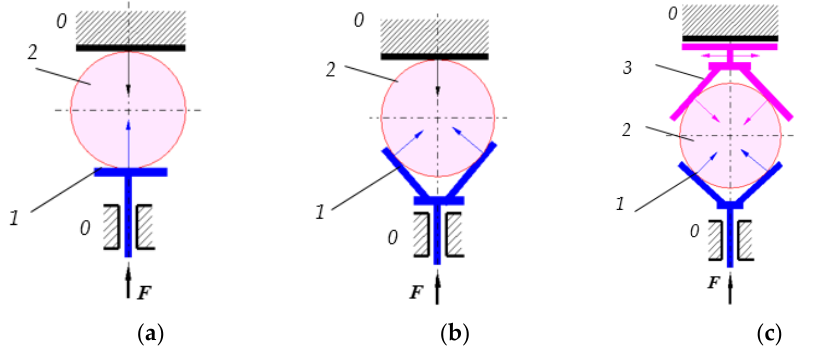
Figure 8. Loading schemes of a compact disc: ( a ) two concentrated forces; ( b ) three concentrated forces; ( c ) four concentrated forces; 0—ground; 1, 3—supports; 2—compact